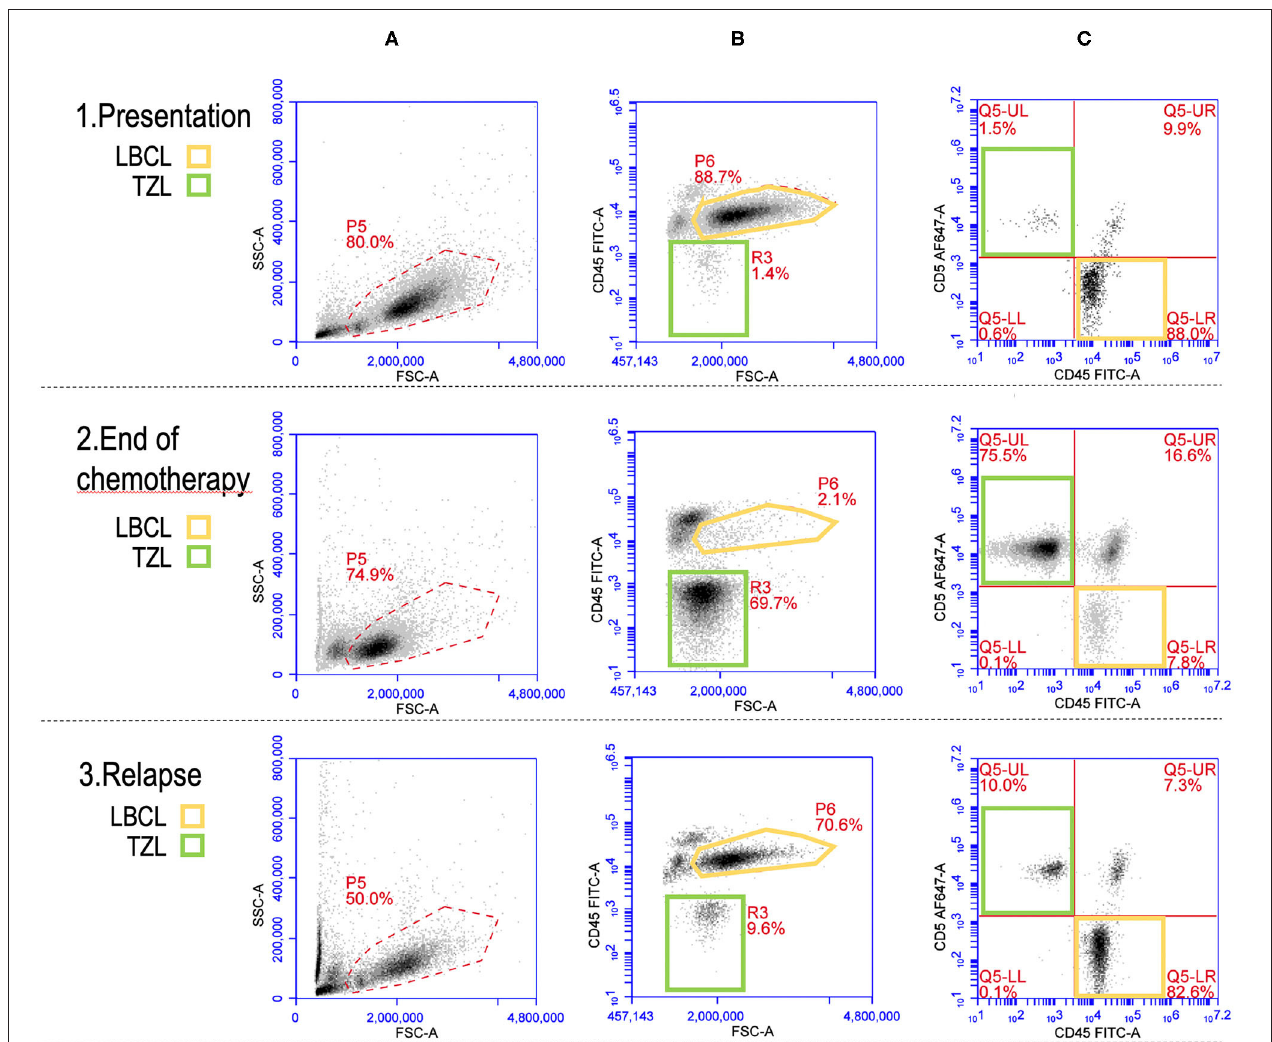
FIGURE 3 | Flow cytometric picture of a large B-cell lymphoma (LBCL) and a concurrent T-zone lymphoma (TZL) at presentation (row 1), end of CHOP chemotherapy (row 2), and relapse of LBCL (row 3). Yellow gates (P6 and Q5-LR): LBCL cells. Green gates (R3 and Q5-UL): TZL cells. (A) plots (FSC vs. SSC): “morphologic” presentation of the whole nodal population with gate (P5) activated for the analysis in plots (B,C) ; a prevalence of large-sized cells (higher FSC) is recognizable at presentation and relapse while small and medium-sized cells are predominant at the end of chemotherapy. (B) plots (FSC vs. CD45): CD45 expression according to cells size (FSC); the main population is represented by large CD45 + cells (P6, yellow) at presentation and relapse while it is made of medium CD45 − cells (R3, green) at the end of chemotherapy. (C) plots (CD45 vs. CD5): most of the events are CD45 + CD5 − (Q5-LR, yellow) at presentation and relapse while CD45-CD5 + cells (Q5-UL, green) represent the majority of the population at the end of